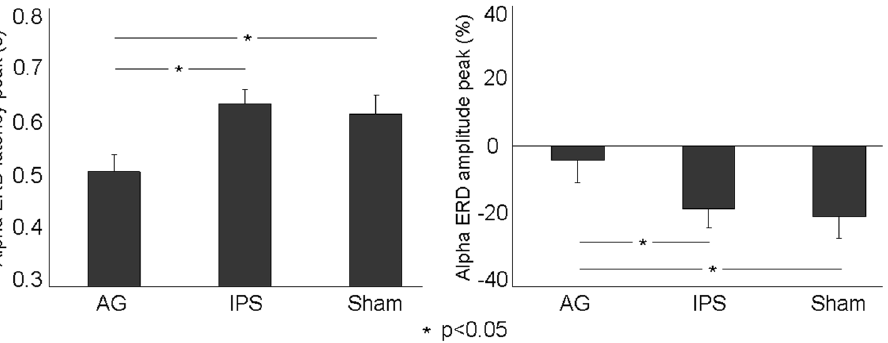
Figure 3. ( a ) Group mean of the anticipatory alpha peak latency ( ± SE) for the three rTMS Conditions (AG, IPS, and Sham). ( b ) Group mean of the anticipatory alpha peak amplitude ( ± SE) for the three rTMS Conditions (AG, IPS, and Sham). Duncan post-hoc tests: one asterisk (p < 0.05). Overall, both peak latency and amplitude were affected when magnetic stimulation was delivered over AG compared to both Sham and